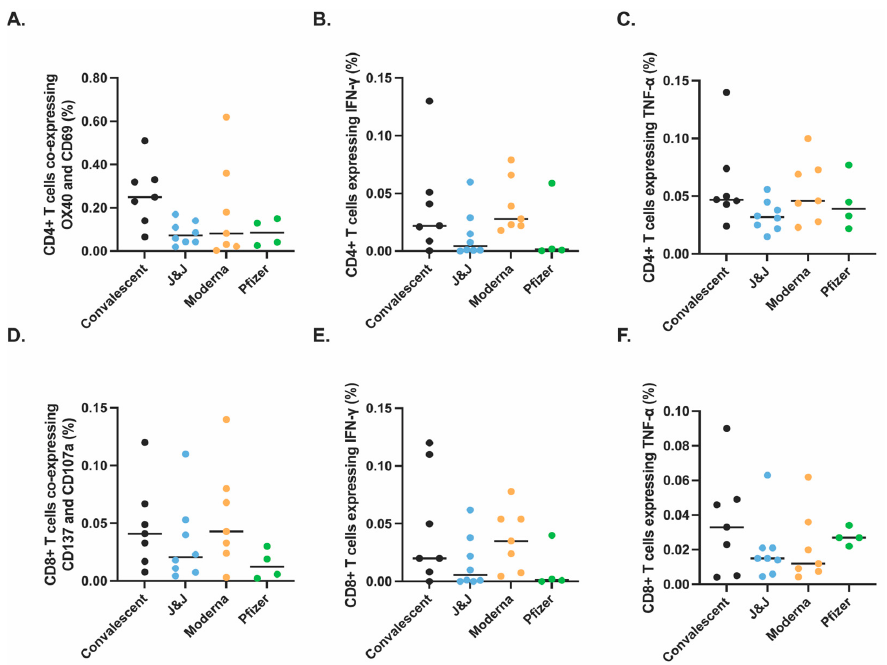
Figure 2. Similar antigen-specific T cells responses observed after vaccination or infection. SARS-CoV-2 specific T cell responses after vaccination or natural infection analyzed by spectral flow cytometry (Figure S1). PBMCs isolated from convalescent (black, n = 7), J&J (blue, n = 8), Moderna (orange, n = 7), and Pfizer (green, n = 4) participants were analyzed for SARS-CoV-2 spike-specific CD4+ ( A – C ) and CD8+ ( D – F ) responses. Significance tested by Kruskal–Wallis test. y -axis indicates proportion of total CD4+ or CD8+ T cells that express the indicated activation markers or cytokines.